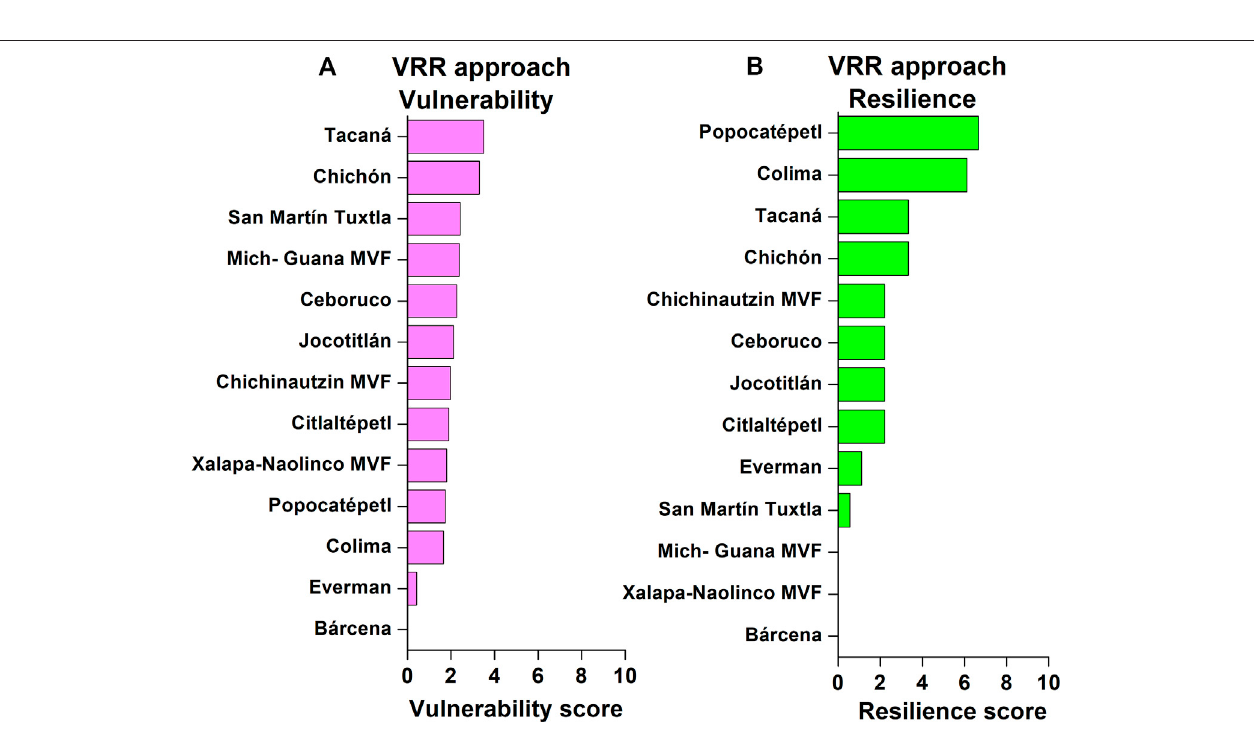
FIGURE 3 | (A) Vulnerability and (B) resilience analysis based on the new ranking strategy for Mexican volcanoes having erupted < 1 ka.